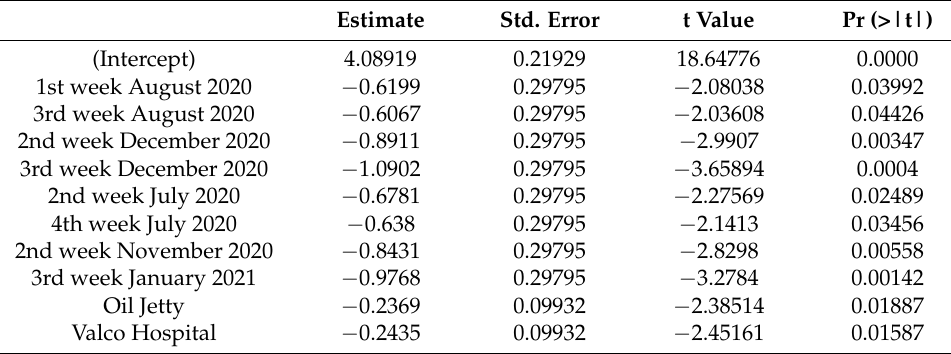
Table 4. Significant variable estimates for PM 2 . 5 .